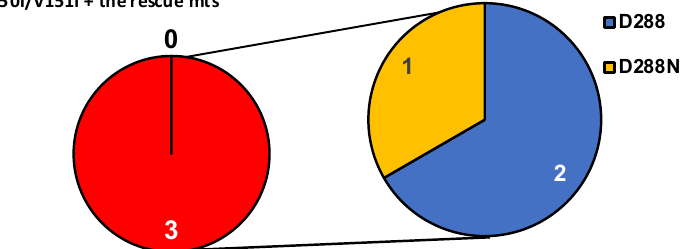
Figure 6. Population analysis of a combination of IN:M50I/IN:V151I mutations with an aa residue at 288 of IN. Population analysis was conducted to determine the diversity of HIV sequences containing IN:M50I and IN:V151 in ( A ) subtypes B, and ( B ) subtype C in the LANL HIV database. All HIV-1 sequences were downloaded from the LANL.GOV website. The sequences containing IN (p31) regions were selected, and only one sequence per patient was used in the analysis. A total of 27 and 3 HIV sequences contained IN:M50I/V151I mutations in subtype B ( A ) and C ( B ), respectively. The aa residue at 288 was analyzed in sequences without rescue mutations (RH:N79S or IN:S17N).